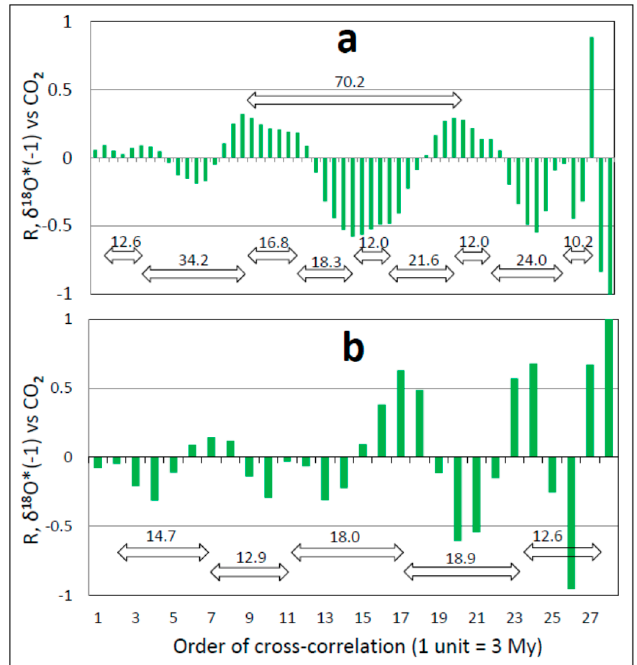
Figure 14. Lagged (serial) cross-correlation coefficient, R , of temperature and atmospheric CO 2 concentration proxies. ( a ) Time period from 174 to 0 Mybp. Average short cycle duration, 17.9 My. Average long cycle duration, 70.2 My. ( b ) Time period from 174 to 87 Mybp. Average short cycle duration, 15.4 My. Otherwise as in the legend of Figure 12.